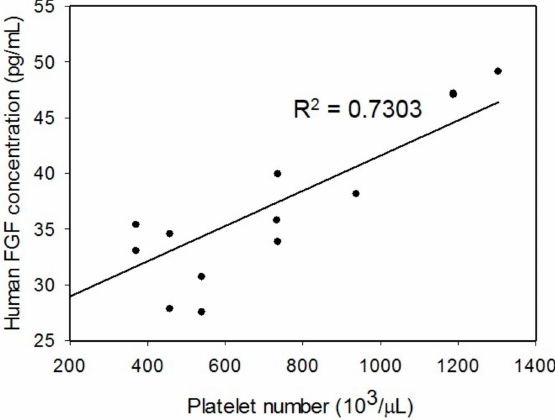
Figure 7. Correlation between the platelet number in the PRP and the human FGF concentration. The blood samples were collected from 4 donors in the ages of 49, 50, 70, and 72. The PRP were respectively prepared by A2 and B2 procedures. Each data point represents the result from 1